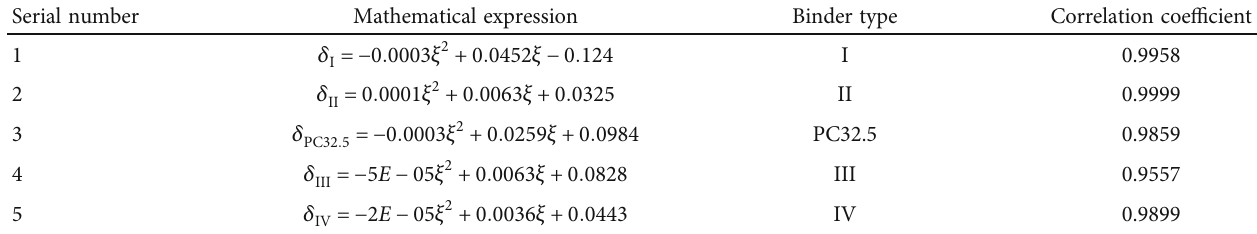
Table 7: Functional relationship of UCS and curing age (1 :8).